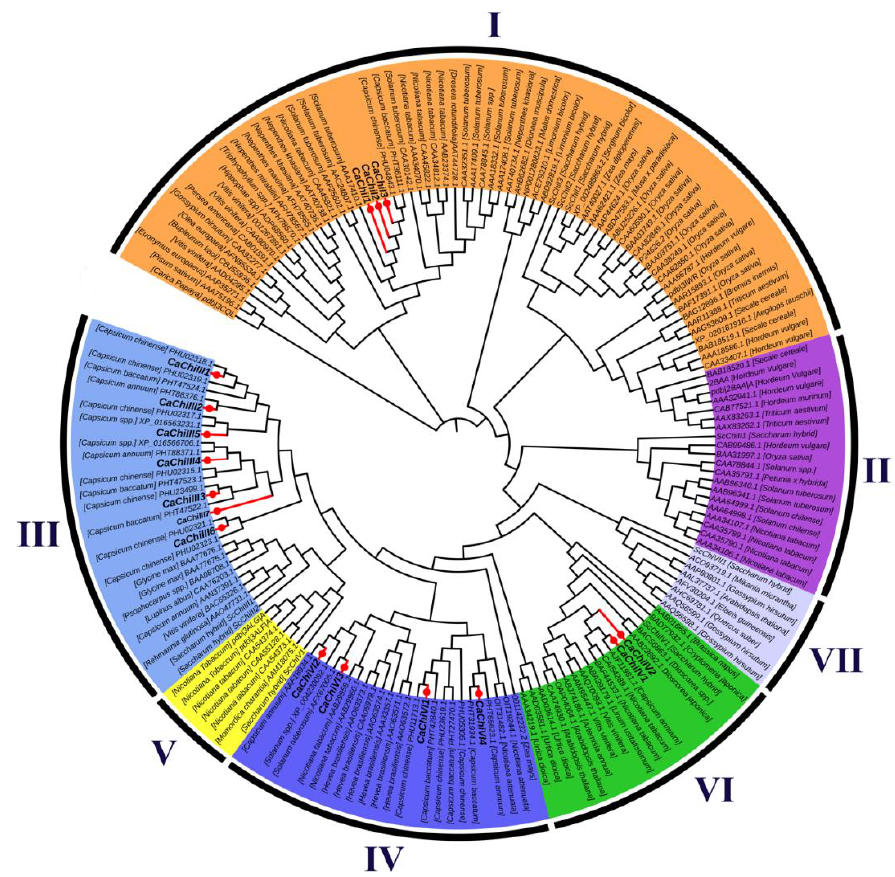
Figure 2. The phylogenic tree of chitin-binding protein family genes in pepper and other plant species. The phylogenetic tree was built using the neighbor-joining method and diagram was drawn using online iTOL (Available online: https://itol.embl.de/). The number of chitin-binding protein family genes were divided in I–VII well conserved groups.